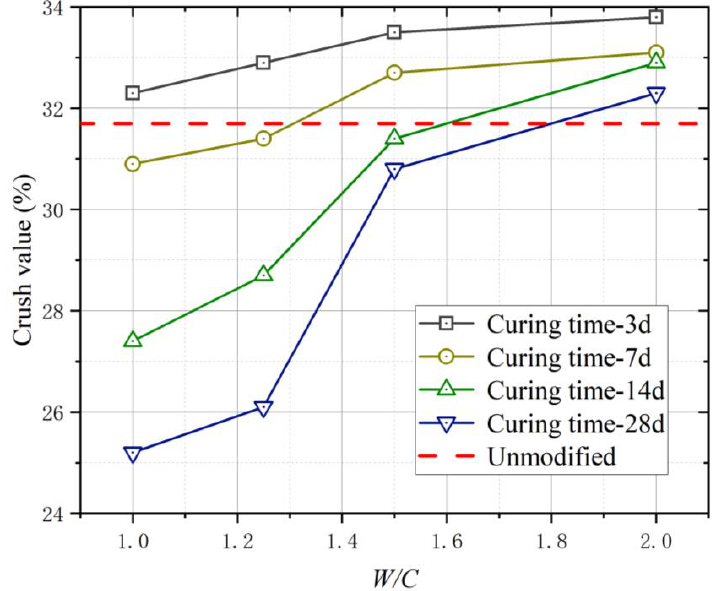
Figure 8. C r of modified coral aggregates with different curing times.